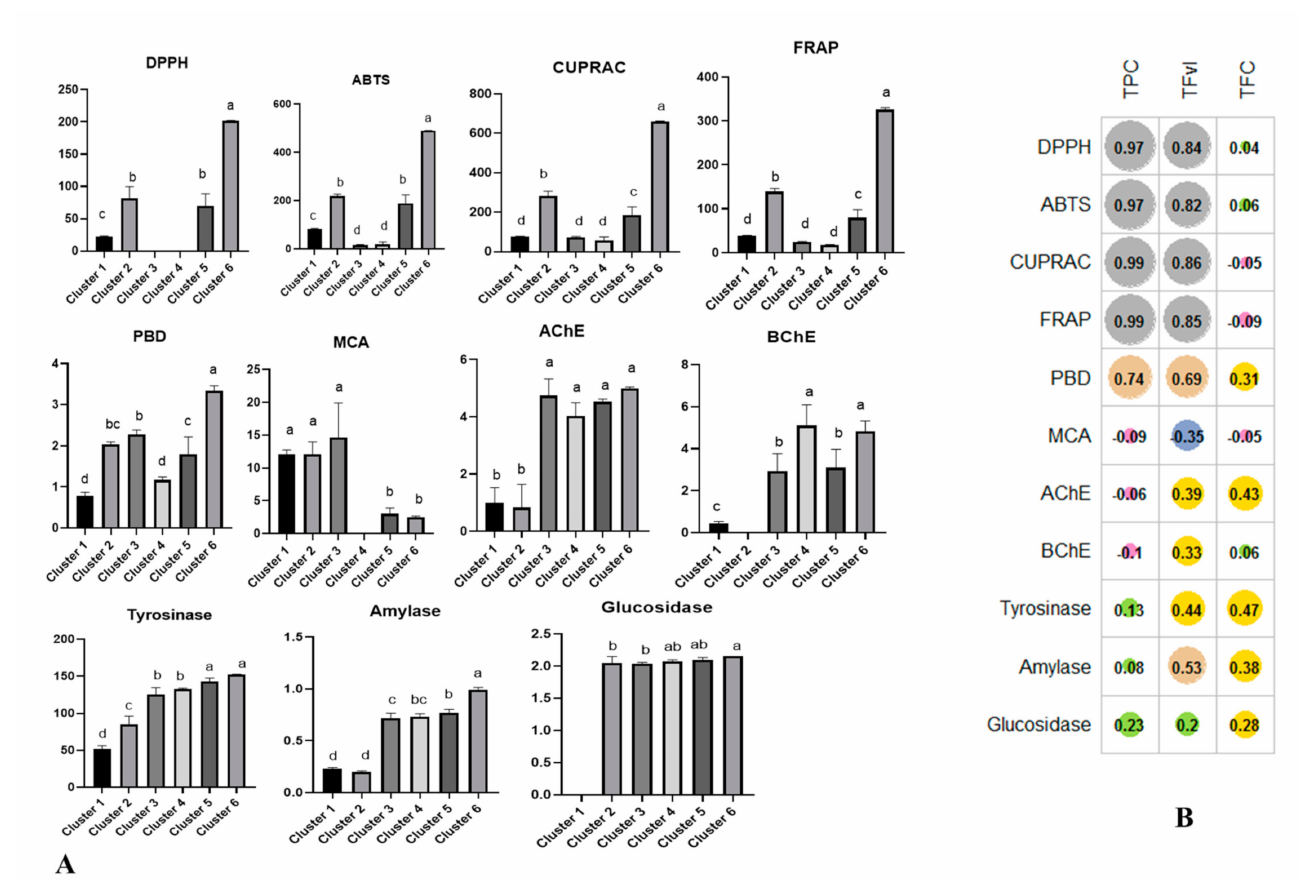
Figure 10. Investigation of biological activities characterizing the di ff erent clusters and their relationship with phenolic contents. ( A ), Comparison in obtained clusters; ( B ), Pearson correlation between total bioactive compounds and biological activity assays. Di ff erent letters (a–d) indicate significant di ff erences in the